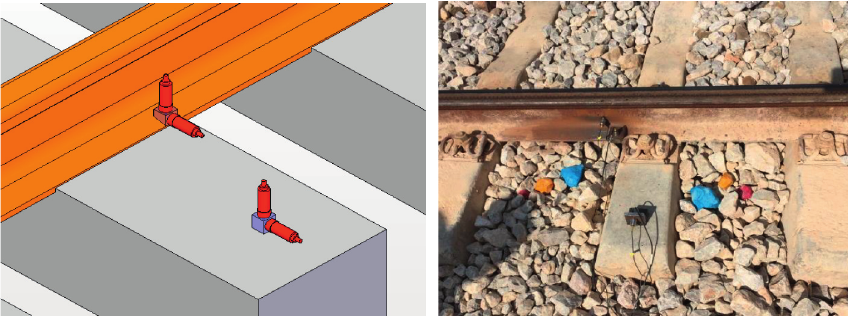
Figure 4: Schematic diagram of sensor installation on the rail and sleeper.